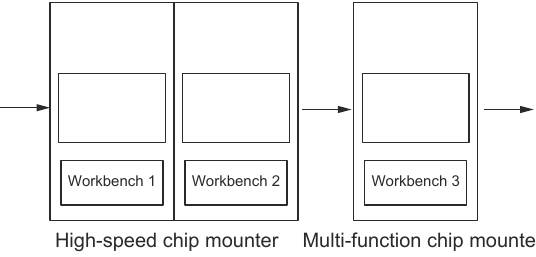
Fig. 1 Structure of the SMT production